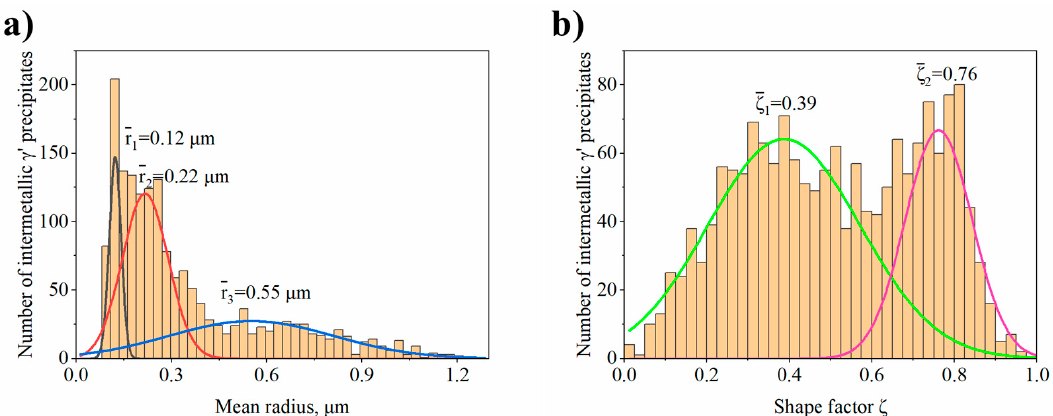
Figure 4. Microstructure of precipitates in a dendrite arm: a ) secondary γ '; b ) secondary and fine tertiary γ '.